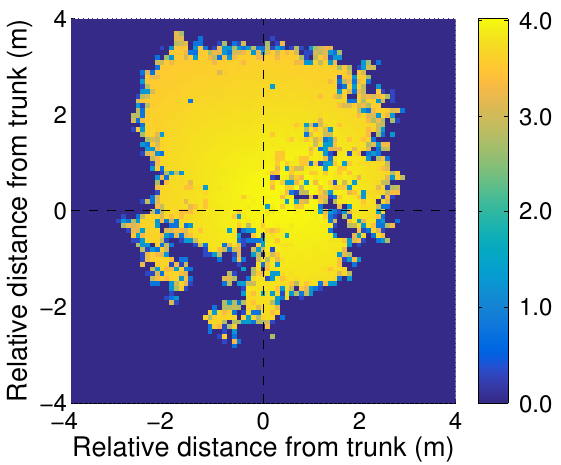
Figure 12. The leaf area calculated by simulation results of the model tree.